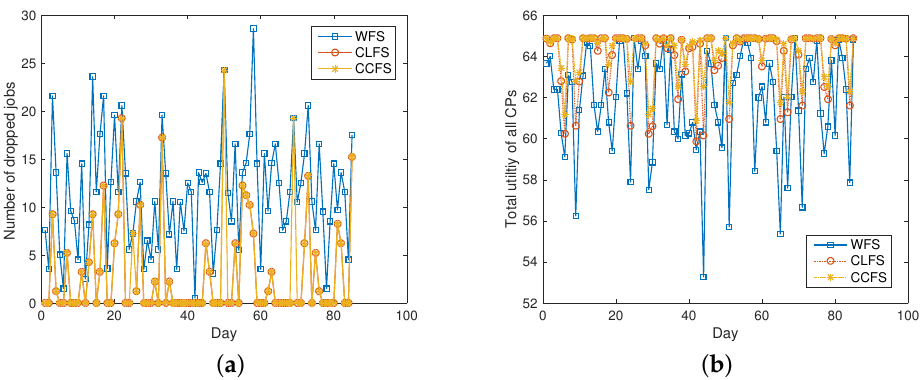
Figure 4. Three-player scenario ( λ 1 = 20, λ 2 = 40, λ 3 = 60). ( a ) The numbers of dropped jobs under the three solutions; ( b ) the utility under the three